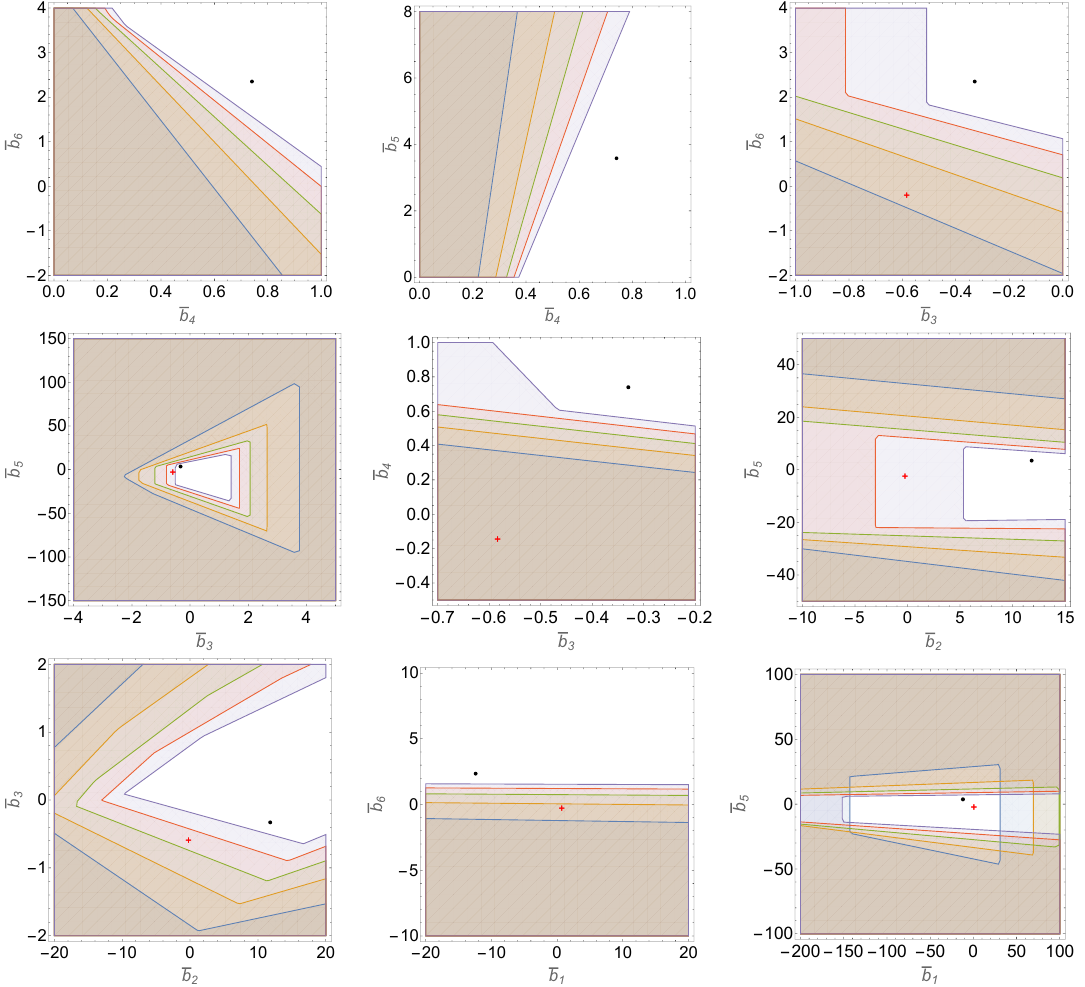
Figure 11 . 2D sections of the improved constrained b i space. The 2D sections are obtained by setting the other 4 parameters to the central values of the (cid:12)t (4.12). The black point represents the central values of the (cid:12)t (4.12) with inputs from the experimental data and theoretical estimates, and the red cross represents the theoretical point computed from the Weinberg Lagrangian. Di(cid:11)erent lines corresponds to di(cid:11)erent choices of (cid:15) (cid:3) M (cid:25) : 341 MeV (Orange), 388 MeV (green), 430 MeV (Red), 468 MeV (Purple), original Y bounds (blue). To be continued in (cid:12)gure 12. using it for the improved Y bounds, and employ the same b constants in eq. (4.12), i the energy scale (cid:15) (cid:3) M at which the improved t = 1 : 1 ; N = 2 ; M = 8 bound becomes (cid:25) negative is at 305 MeV; see (cid:12)gure 13. In comparison, using the original amplitude, the t = 1 : 1 ; N = 2 ; M = 2 bound only breaks down after 500 MeV. One need, however, to